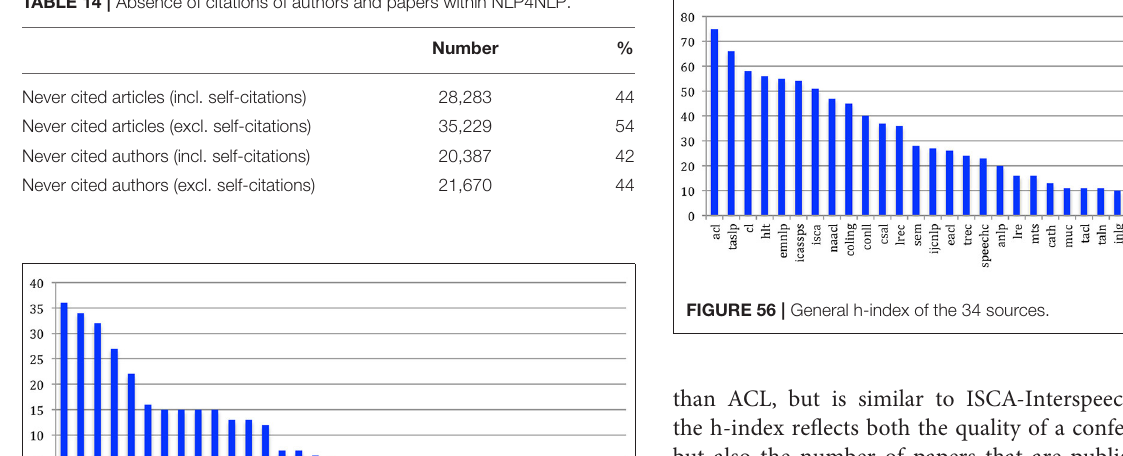
TABLE 14 | Absence of citations of authors and papers within NLP4NLP.